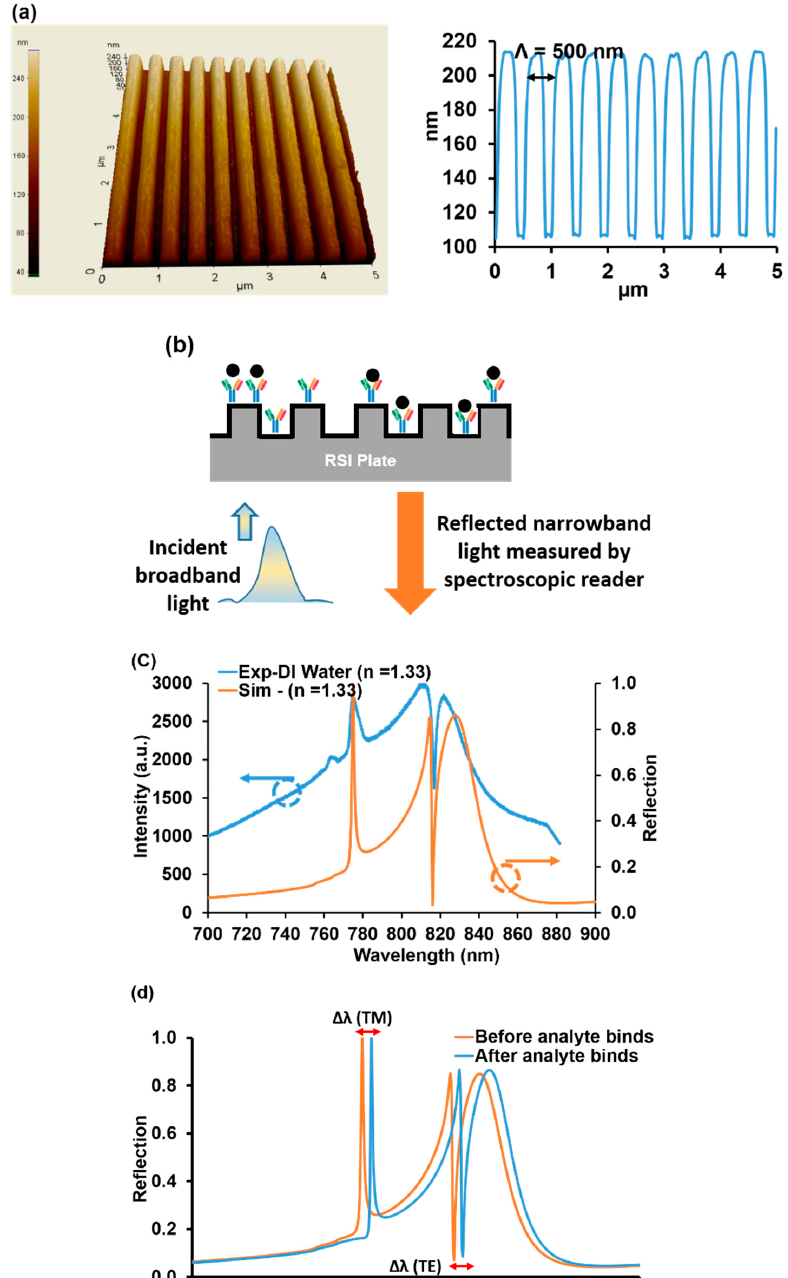
Figure 1. ( a ) 3D atomic force microscope (AFM) image of a guided-mode resonance (GMR) sensor surface with a grating period of ~500 nm and the attendant measured profile. ( b ) Schematic of a GMR sensor operating in reflection mode. Broadband unpolarized light was incident on the sensor in the form of a Gaussian beam. The reflected spectral response was monitored in real-time with an optical spectrum analyzer. ( c ) A measured reflection spectrum of a GMR sensor vs. a rigorous coupled-wave analysis (RCWA) calculated spectrum. ( d ) Calculated reflection spectrum for TM and TE mode resonance by RCWA. Shown is a computed GMR optical biosensor resonance-peak shift due to a change of refractive index from 1.34 to 1.44. In the subsequent sections, these shifts are monitored to quantify the NPY